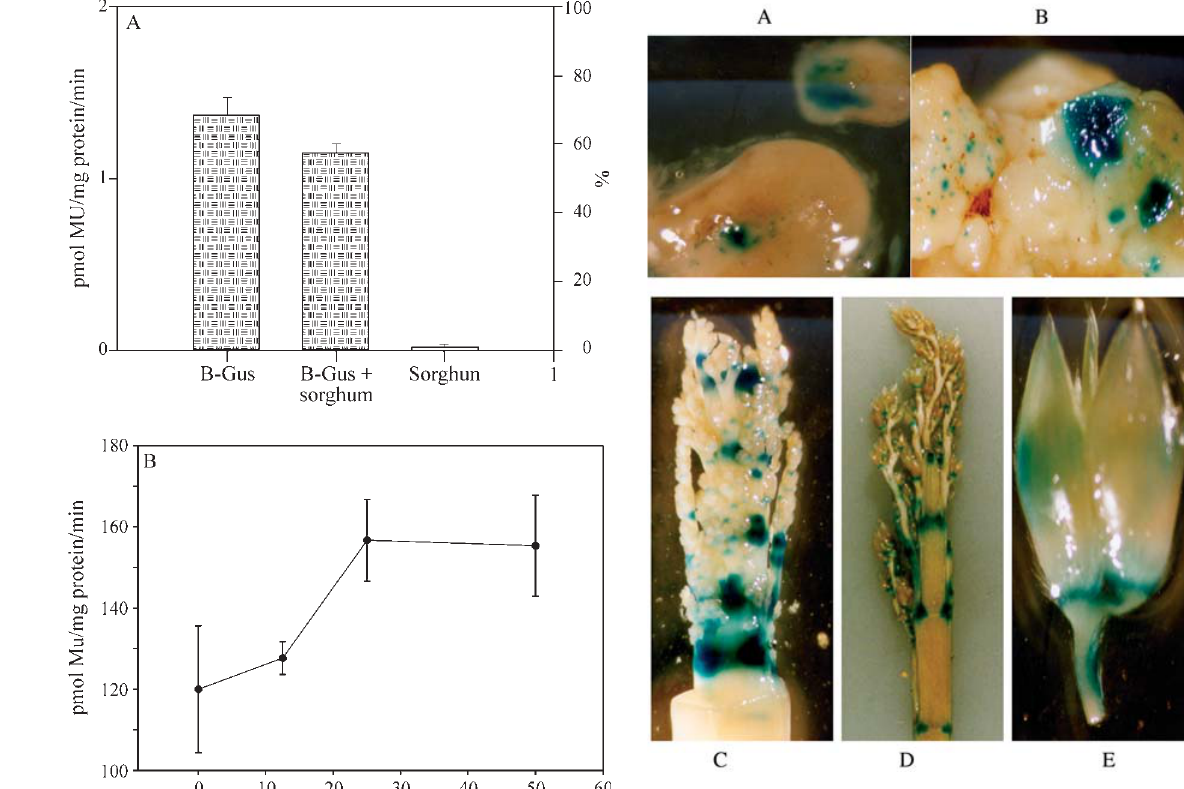
Figure 5 - GUS expression in immature embryos (A), transformed callus (B), young intact inflorescence (C), young inflorescence cut longitudi- nally (D), and floret before anthesis (E). Note that GUS activity is more visible in tissues in active growth such as nodes of